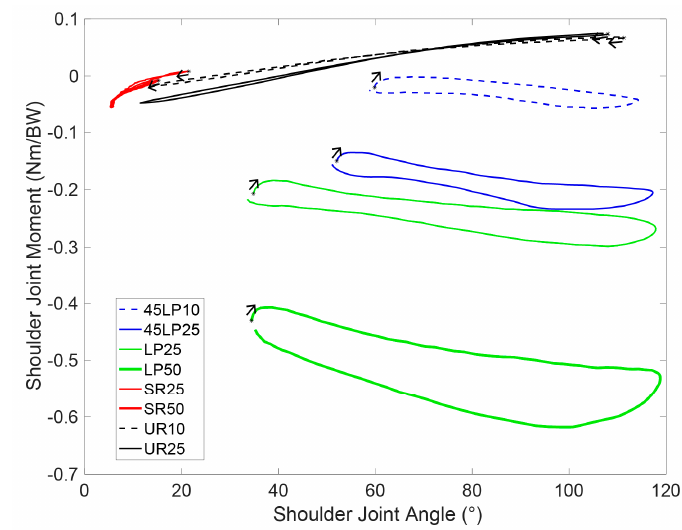
Figure 3. Normalized moments versus angles in the frontal plane (adduction (+) and abduction ( − )) in the shoulder joint, averaged over all subjects.